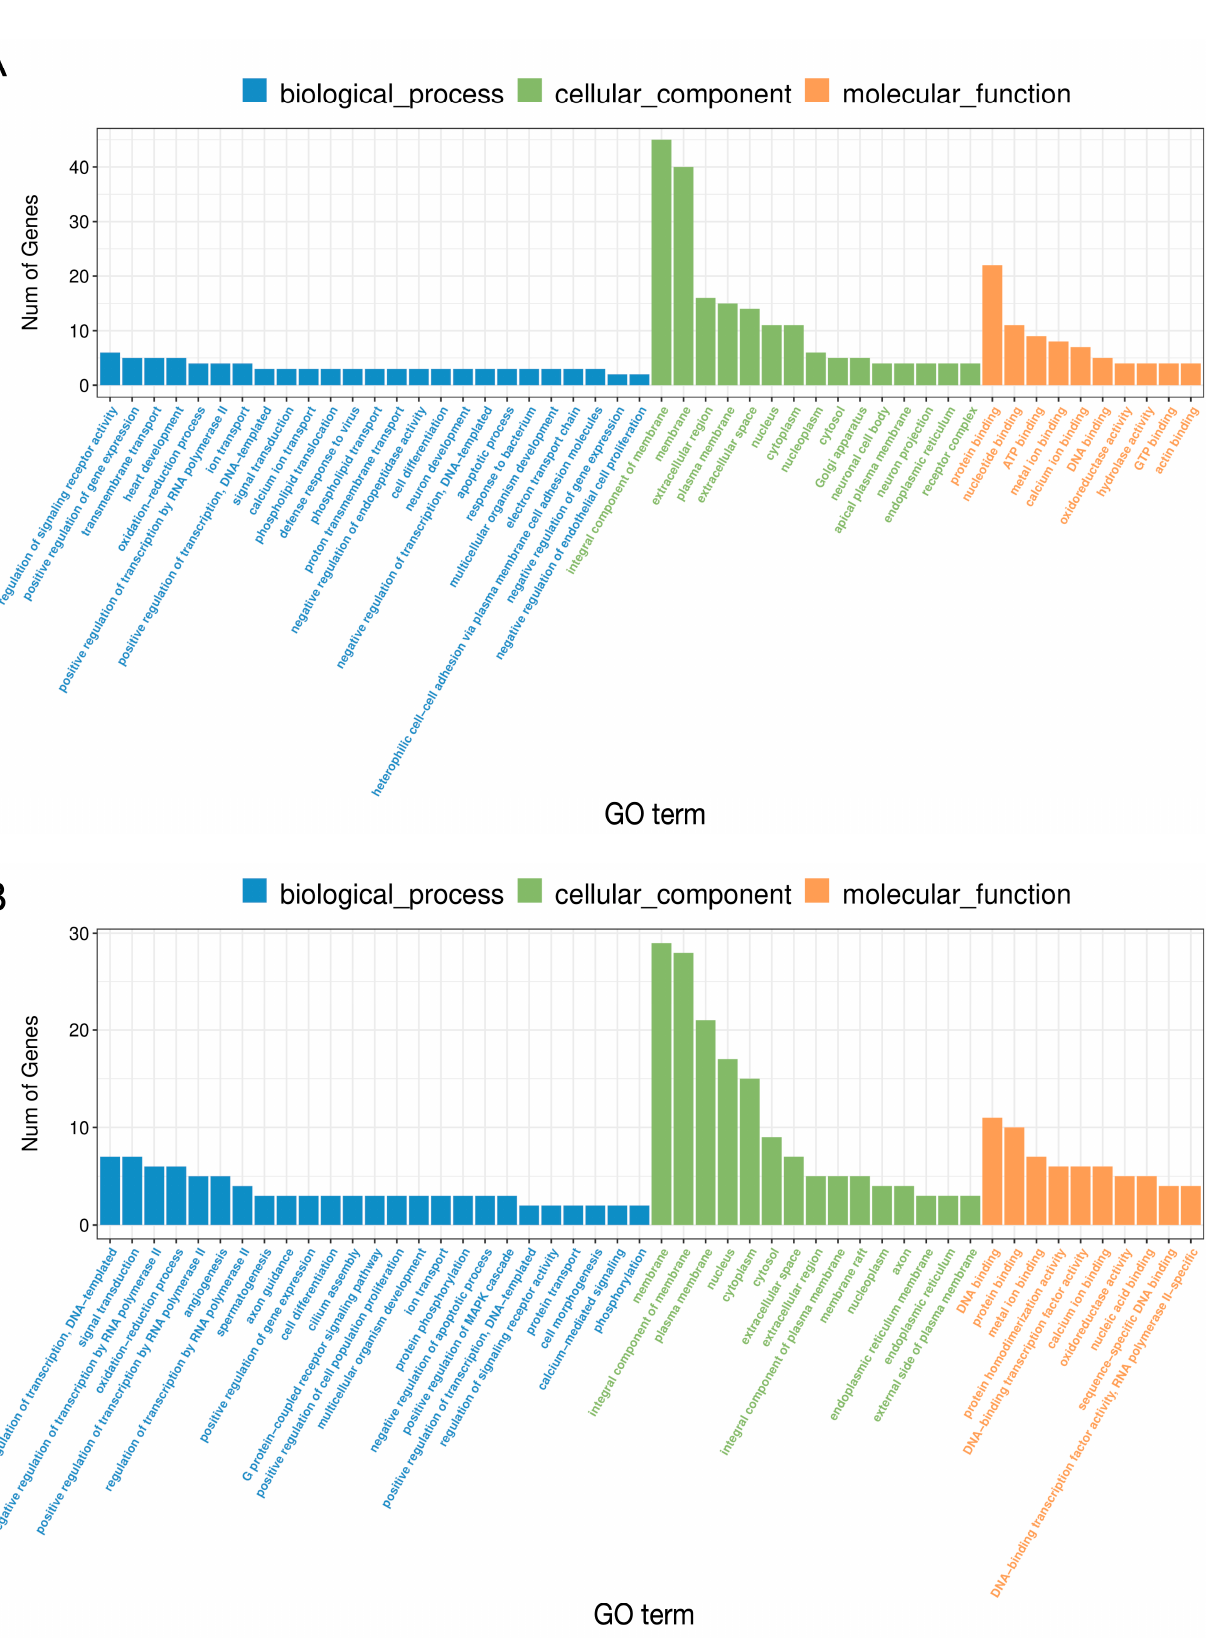
Figure 3. Hierarchical clustering heatmap of differentially expressed genes after LPS ( A ), GW0724 at a concentration of 1 μ mol/L ( B ), GW0724 at a concentration of 10 μ mol/L ( C ), or GSK3787 ( D ) treatment of porcine corpus luteum in the late-luteal phase of the estrous cycle.